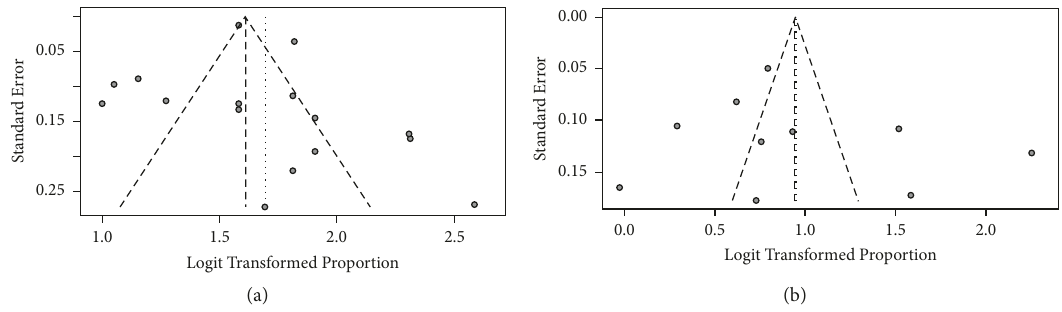
Figure 4: (a): Funnel plot for assessing publication bias for studies that caries prevalence in primary teeth reported. (b): funnel plot for assessing publication bias for studies that caries prevalence in permanent teeth